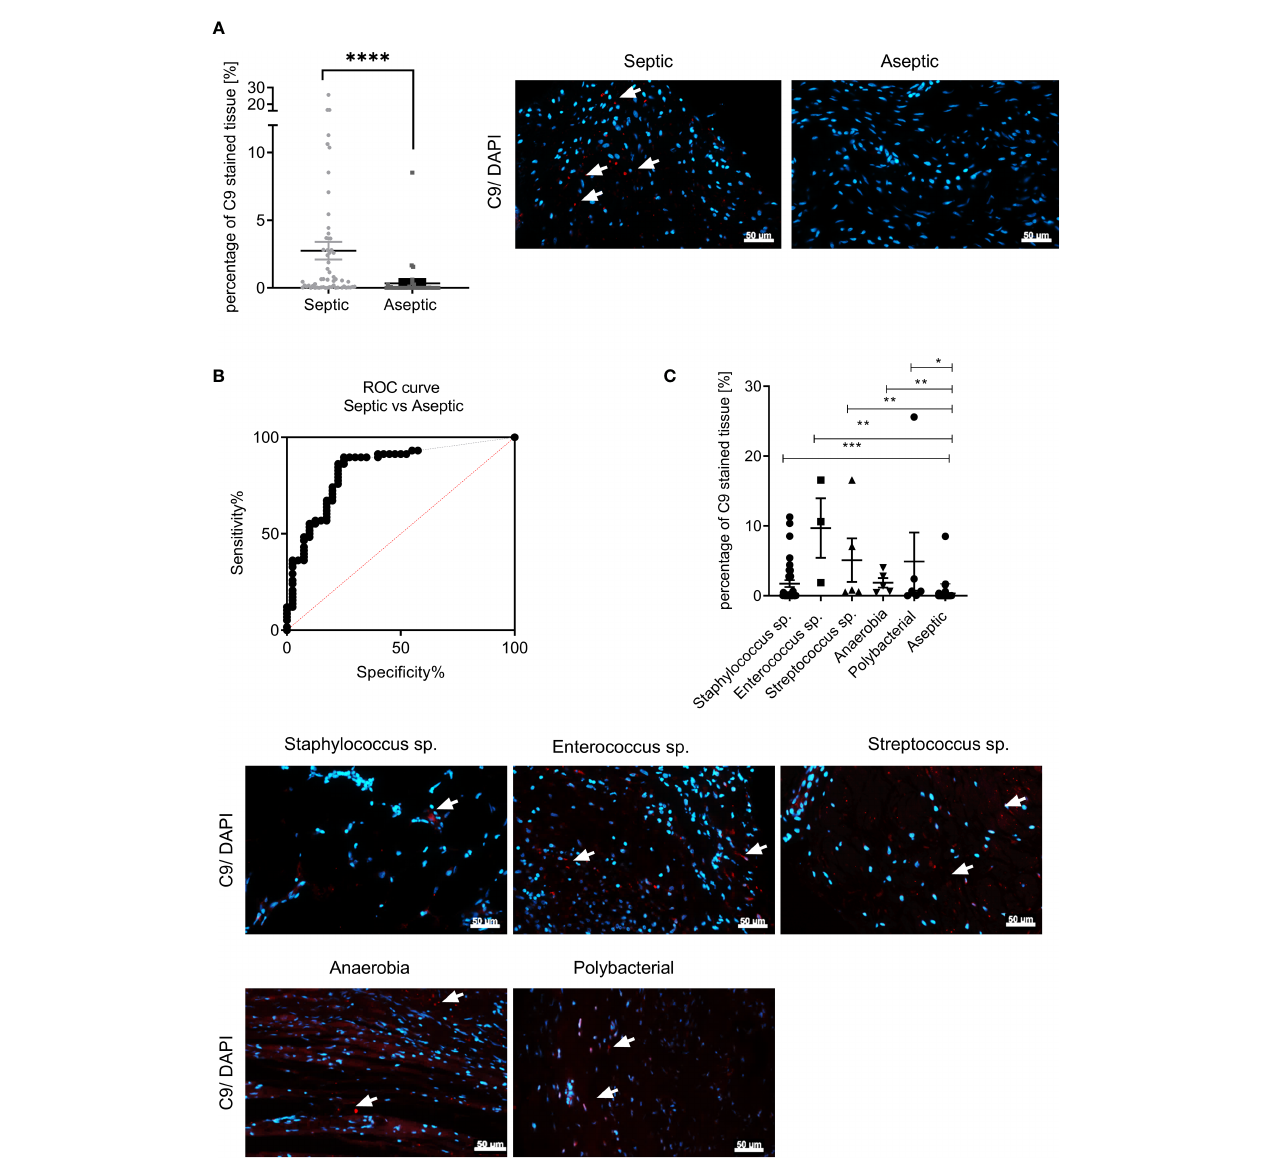
FIGURE 2 C9 immunostaining of periprosthetic tissue could serve as potential biomarker for PJI identi fi cation. (A) The statistical analysis of the percentage of red fl uorescence within the total tissue area (C9 immunostaining) of the aseptic (dark grey, N = 40; n = 120) and septic (light grey, N = 58, n = 174) cohort can be seen as a scatter dot plot. The values indicate the percentage of C9 immunostaining. Three images for each patient sample were analyzed (Mann-Whitney test: p < 0.0001). A representative picture for a septic (left) and an aseptic (right) sample are depicted. (nuclei: blue, anti-C9 immunostaining: red). White arrows indicate C9 stained tissue area. The scale bar (white bars) indicates 50 µm and pictures were taken at 400x magni fi cation. (B) The ROC-curve for individual percentages of C9 stained tissue area for septic and aseptic samples. The area under the curve is 0.84. The sensitivity of 89% (95% of Cl: 78.83% to 96.11%) and the speci fi city of 75% (95% of Cl: 58.80% to 87.31%) were calculated using the Youden ’ s criteria (red dashed line). (C) Representative immunohistochemical staining of C9-antibody (red) in periprosthetic tissue of patients with an PJI caused